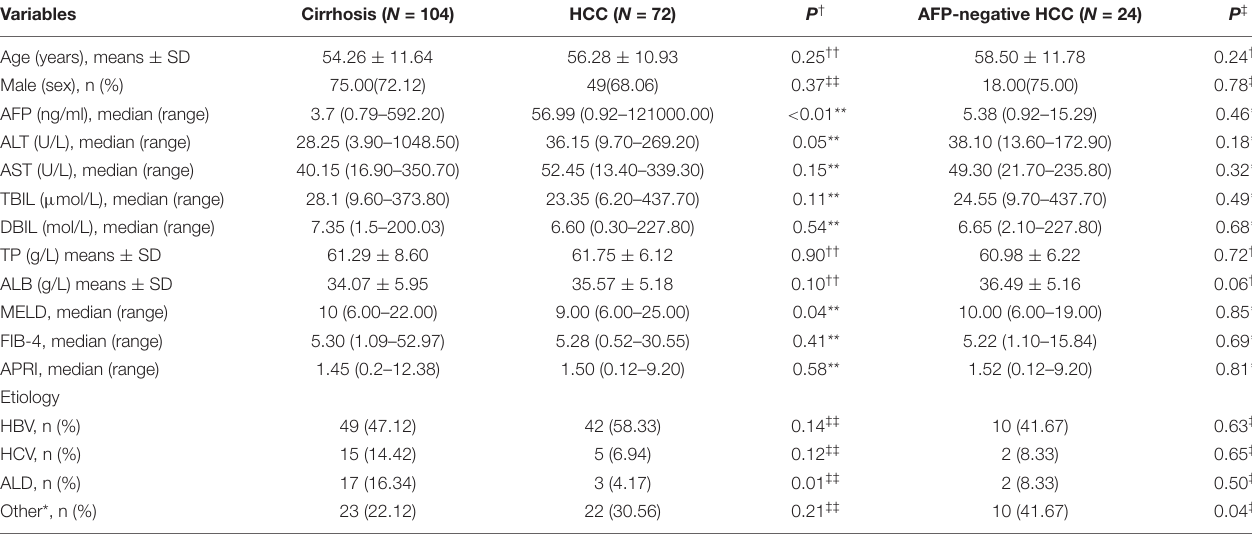
TABLE 1 | Demographic and clinical characteristics of patients. Variables